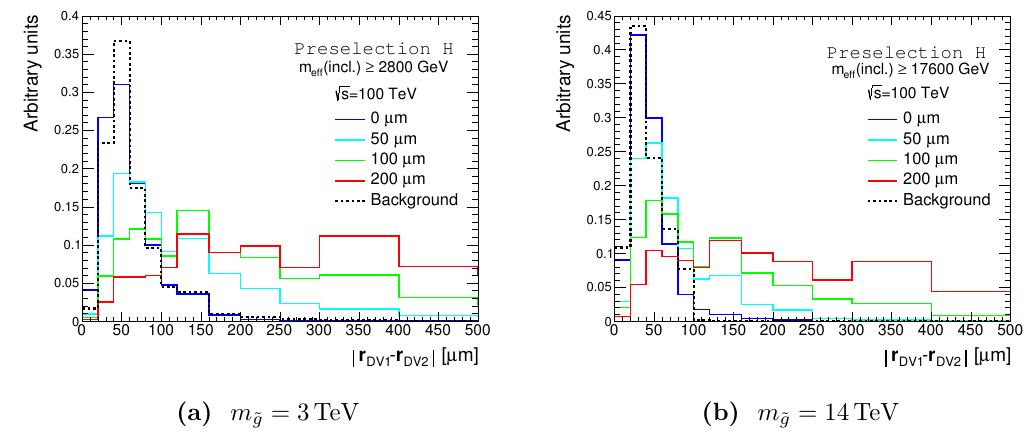
Figure 18. The distributions of j r (cid:0) r j for a gluino with di(cid:11)erent values of c(cid:28) DV1 DV2 solid lines. The distributions for the SM background events are also shown in the dotted lines. We have imposed preselection-H , and m e(cid:11) (incl : ) > 2800 GeV (17600 GeV) in (cid:12)gure 18a ((cid:12)gure 18b).